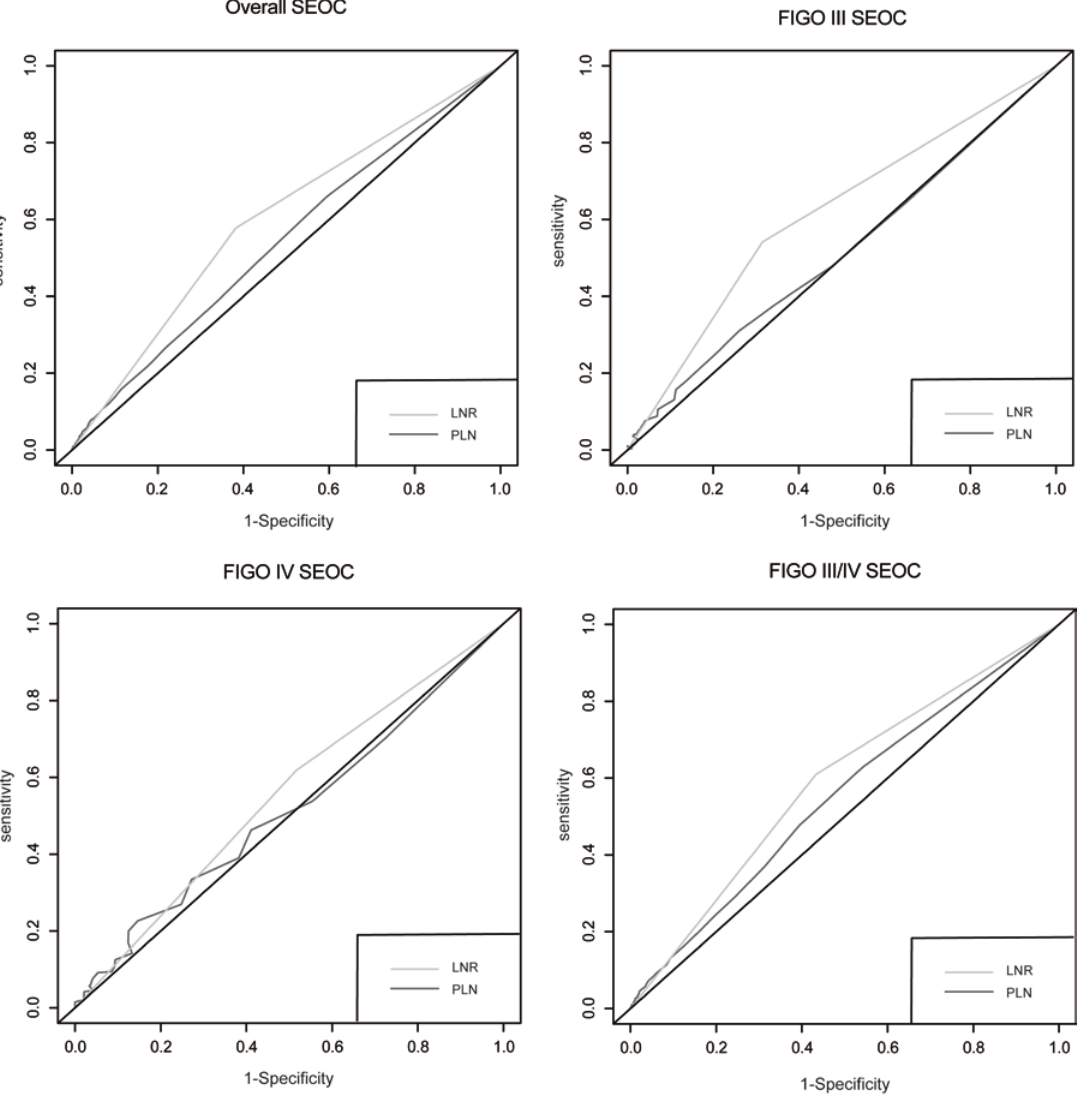
Figure 3: Survival prediction model under the comparison of LNR and PLN in SEOC patients of nodal positive (A), stage-III(B), stage-IV (C) and in stage-III/IV(D),